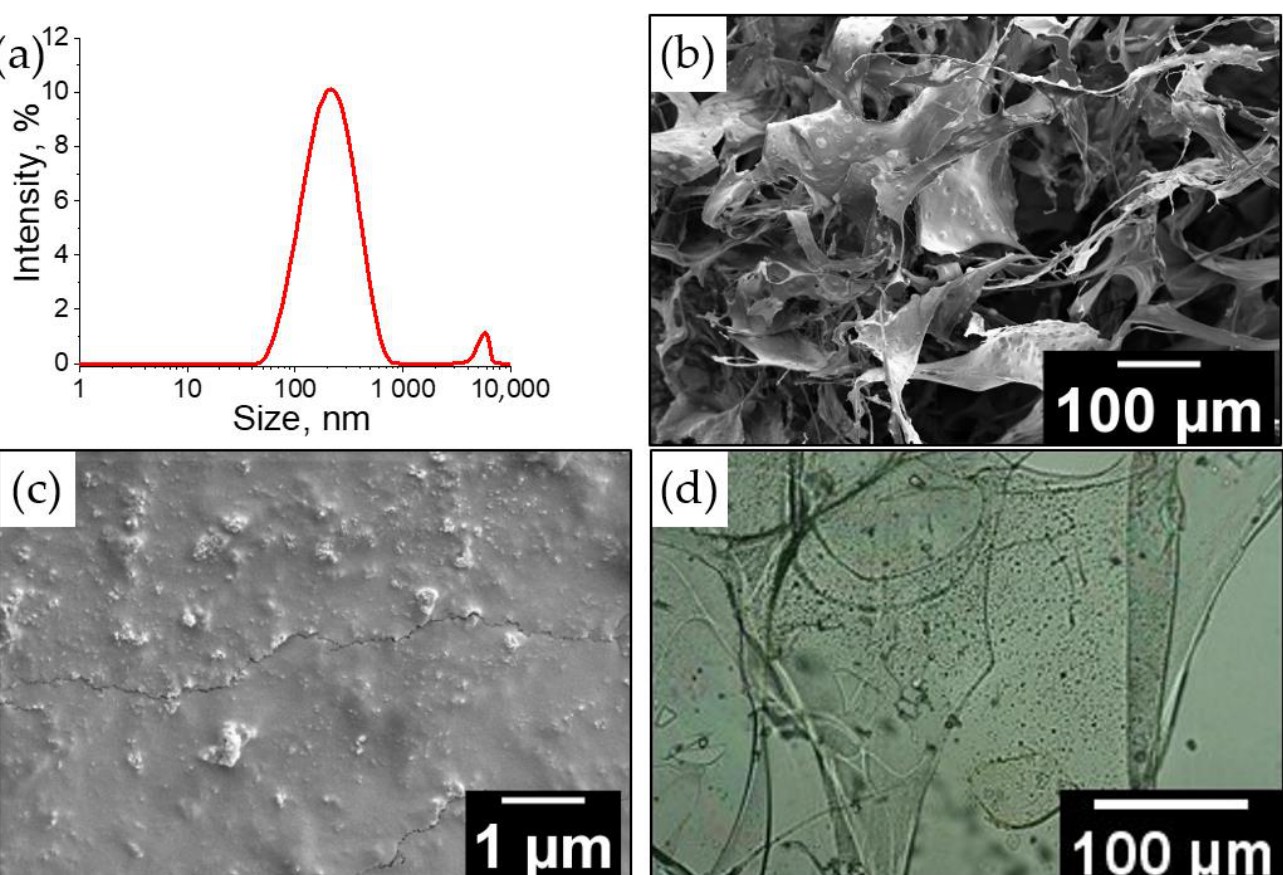
Figure 5. DLS for DNDs ( a ); SEM ( b , c ) and optic microscopy ( d ) images of cryogels obtained in the presence of 3 wt% of DNDs.